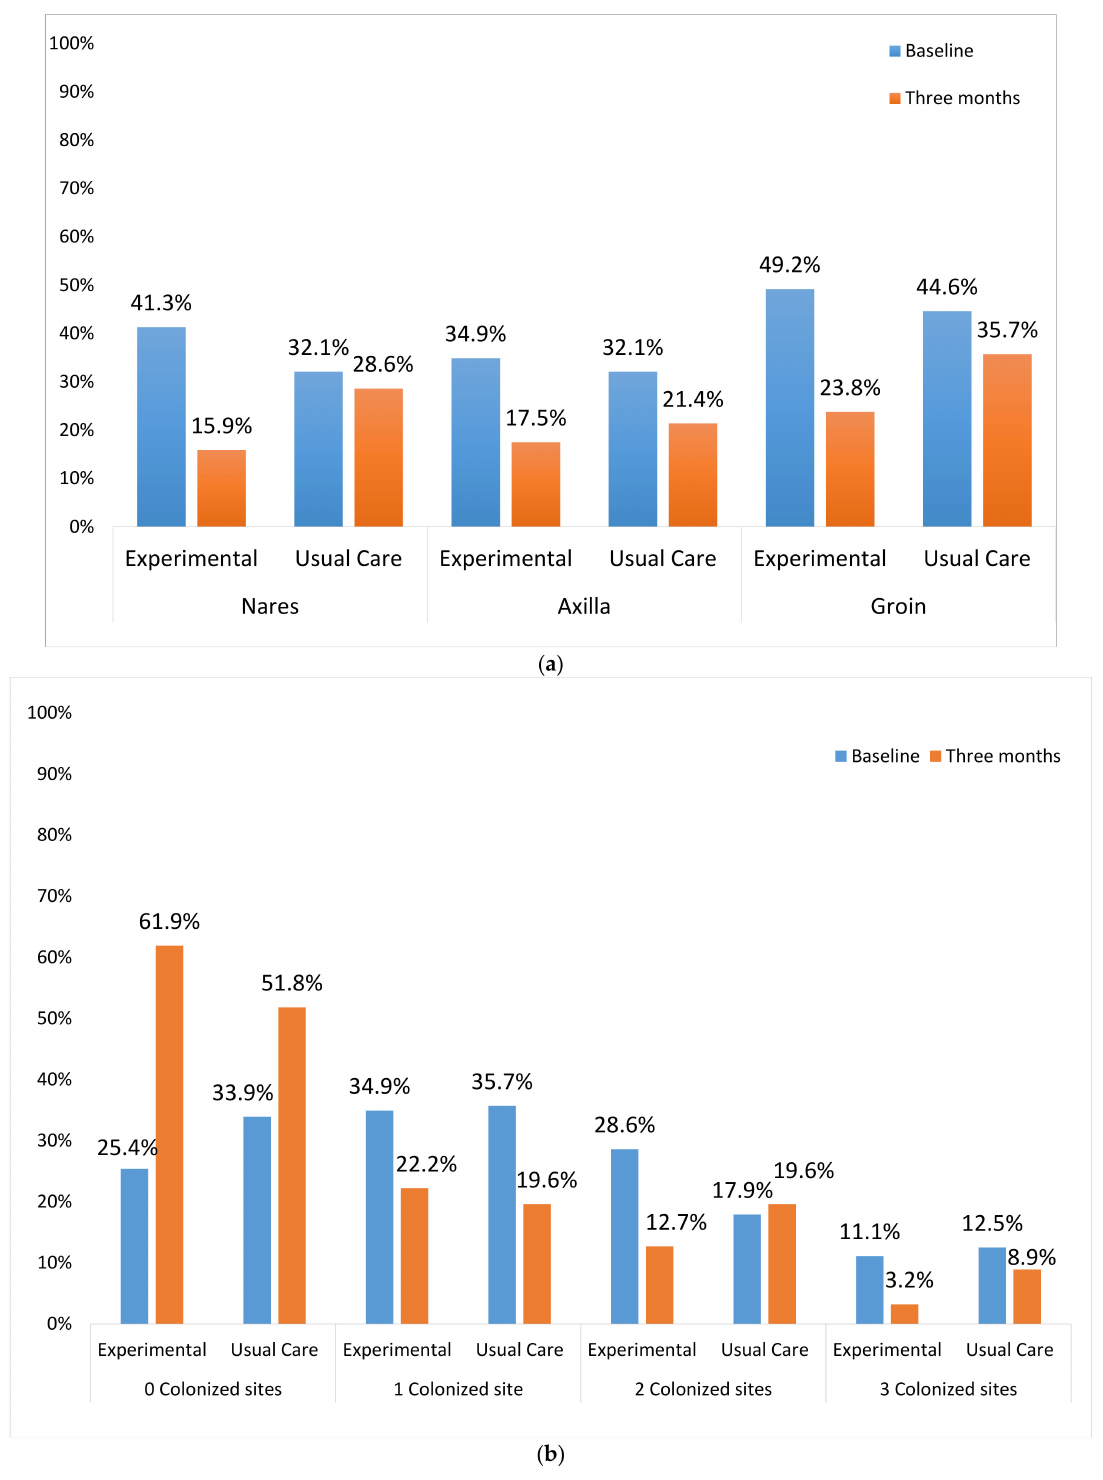
Figure 2. ( a ) Proportion of Index Patient S. aureus Colonization by Colonization Site at Baseline and Three Month Follow-up Household Visits. ( b ) Proportion of Index Patient S. aureus Colonization by Number of Colonized Sites at Baseline and Three Month Follow-up Household